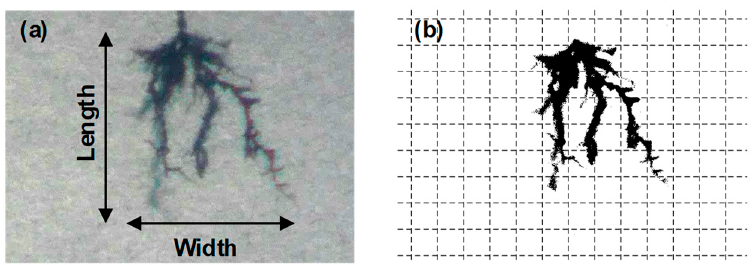
Figure 2. Processing method of electrical tree image. ( a ) The length and width of the electrical tree; ( b ) Image processing method for outlining the treeing area by a binary image.